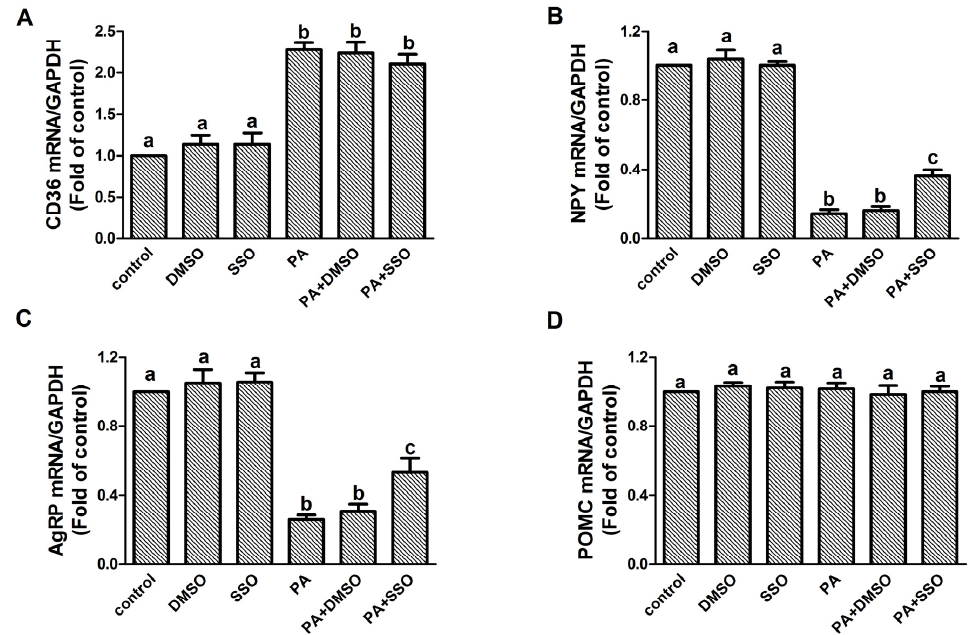
Figure 4. Effect of CD36 blockade on the regulation of NPY and AgRP by PA in N1E-115 cells. N1E-115 cells were pre-incubated with 5 µ mol/L CD36 inhibitor SSO for 30 min before being treated with 10 µ mol/L PA for 20 min. The mRNA expression levels of CD36 ( A ); NPY ( B ); AgRP ( C ); and POMC ( D ) were analyzed by real-time PCR. Quantified mRNA levels were normalized to GAPDH and expressed as fold changes relative to the vehicle-treated control. Data are expressed as means ± SEM of three different experiments. Groups sharing different letters above the bars indicate statistically significant differences ( p < 0.05), while those denoted by the same letters are insignificant ( A – D ). DMSO: DMSO only group; SSO: 5 µ mol/L of SSO group; PA: 10 µ mol/L palmitic acid group; PA+DMSO: N1E-115 cells were treated with 10 µ mol/L palmitic acid for 20 min after pretreatment with DMSO for 30 min; PA+SSO: N1E-115 cells were treated with 10 µ mol/L palmitic acid for 20 min after pretreatment with 5 µ mol/L of SSO for 30